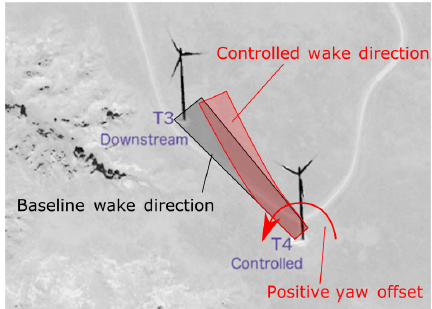
Figure 2. Illustration of wake steering showing that a positive yaw offset is meant to indicate a counterclockwise rotation of the con- trolled